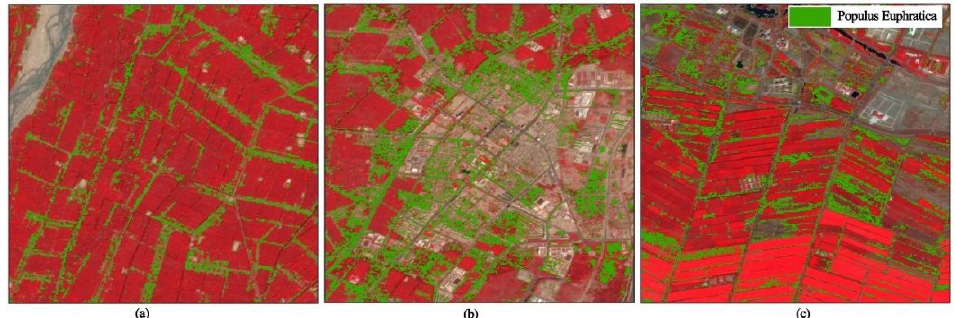
Figure 6. Objects easily misclassified as P. euphratica in the preliminary results. ( a ) All é e trees; ( b ) ur- ban green land; ( c ) farmland. Green patches represent the objects misclassified as Populus euphratica